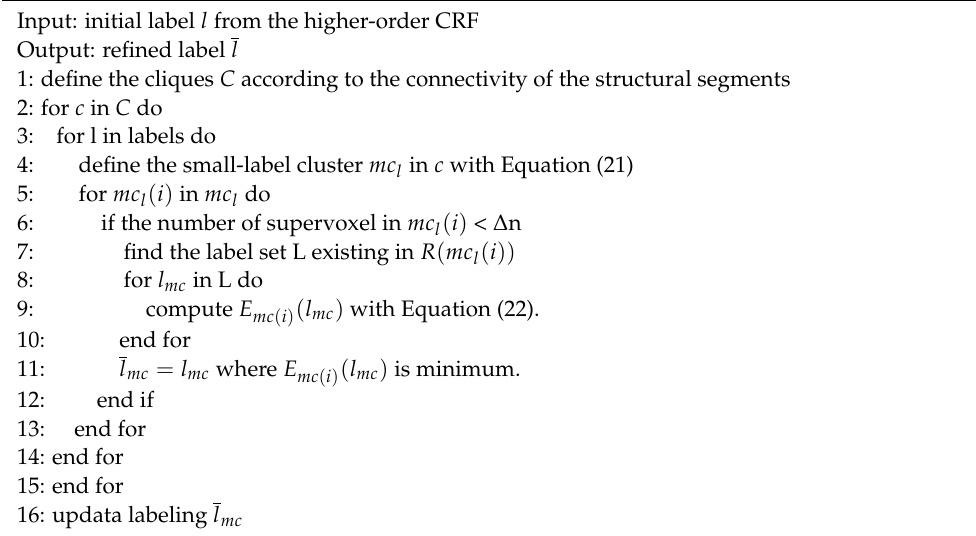
Algorithm 2. Higher-order CRF with small-label cluster